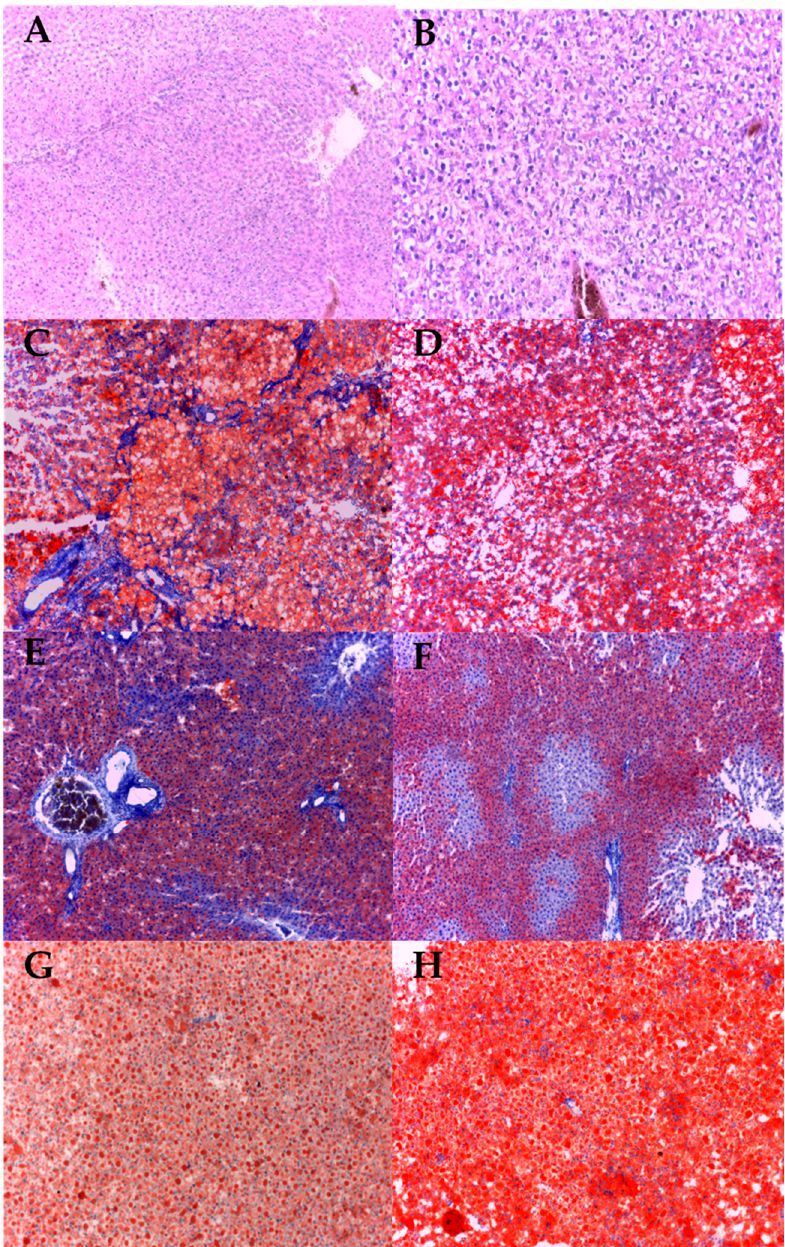
Figure 6. Photomicrographs of liver sections stained with Red Oil staining (200X). The red coloration indicates lipid droplets. ( A ) TG-beta 3 + SD, ( B ) WT + SD, ( C ) TG-beta 3 + HLD, ( D ) WT + HLD, ( E ) TG-beta 3 + HLD + Mtx, ( F ) WT + HLD + Mtx, ( G ) TG-beta 3 + HLD + Ifx, ( H ) WT + HLD + Ifx. WT- wild type; TG-beta 3- transgenic beta 3; SD—standard diet; HLD—high lipid diet; HLD + Mtx—high lipid diet associated with methotrexate; HLD + Ifx—high lipid diet associated with infliximab.